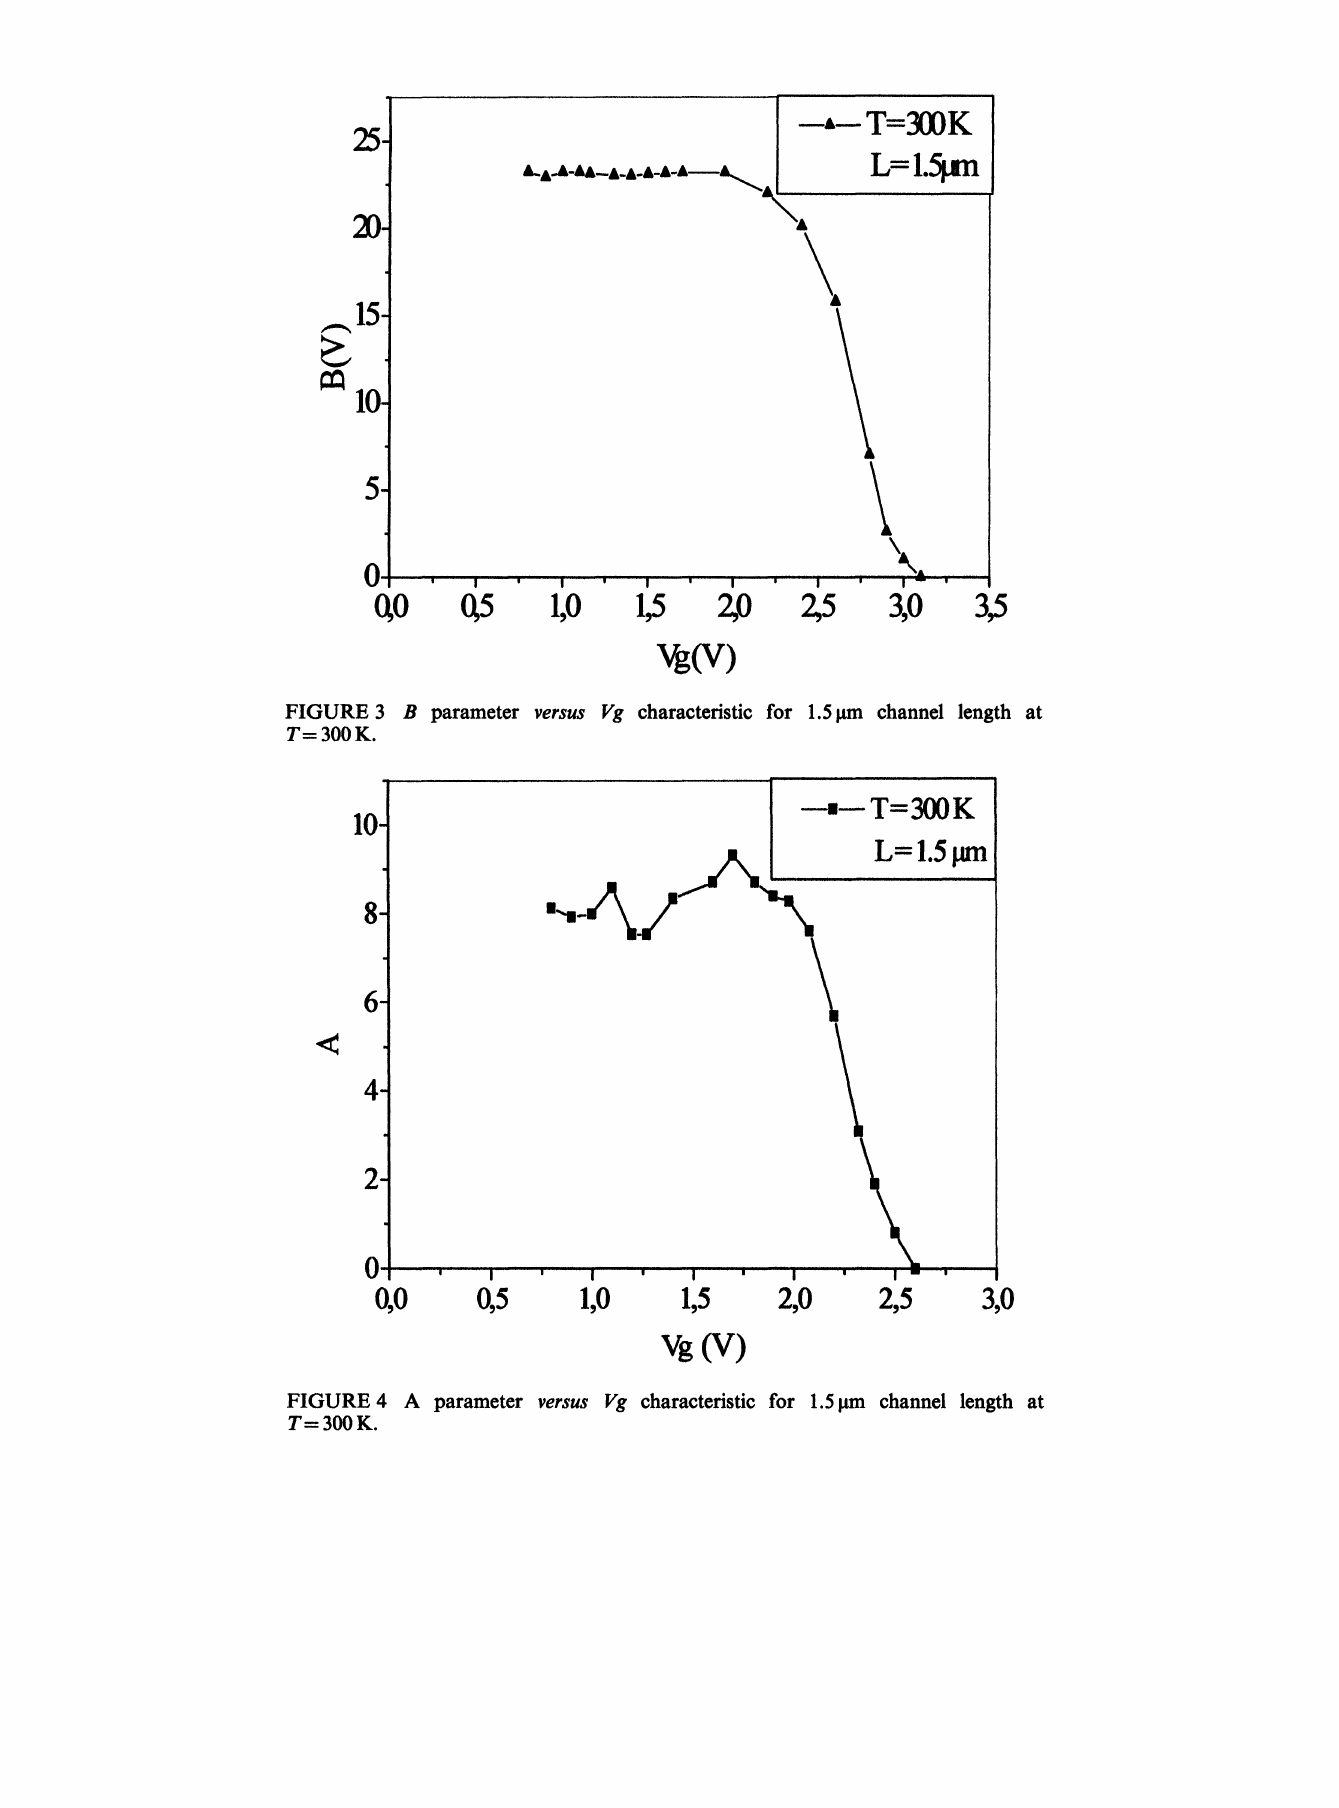
FIGURE 4 A parameter versus Vg characteristic for 1.5tm channel length at T= 300